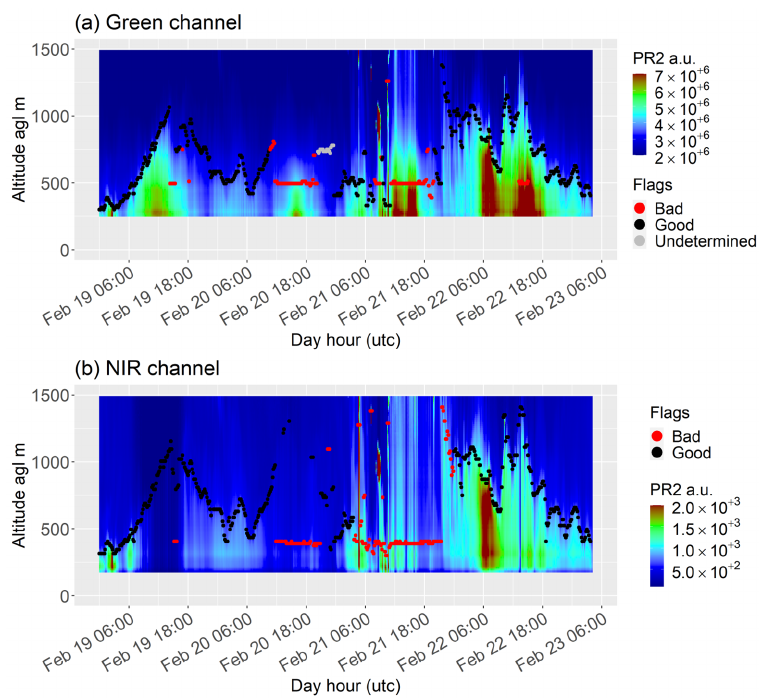
Figure 8. Time series of the PR2 signals inferred from both the green ( a ) and the near ‐ infrared channels (NIR, ( b )) during the WM event. The black dots represent the ABLH applying the Haar wavelet method on the green and near ‐ infrared datasets.